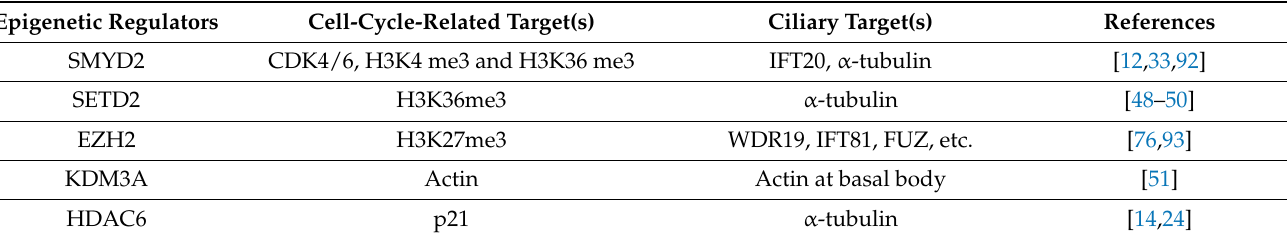
Table 1. The dual roles of epigenetic regulators in cell cycle and ciliogenesis regulation. Epigenetic Regulators Cell-Cycle-Related Target(s) Ciliary